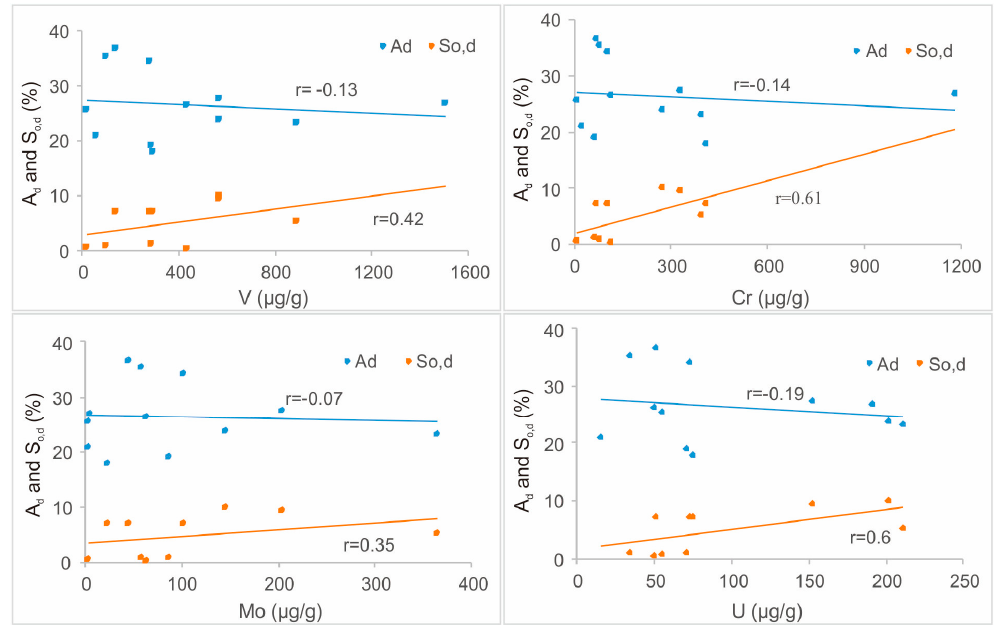
Figure 3. Correlations of elements (V, Cr, Mo, U) and A d as well as S o,d .